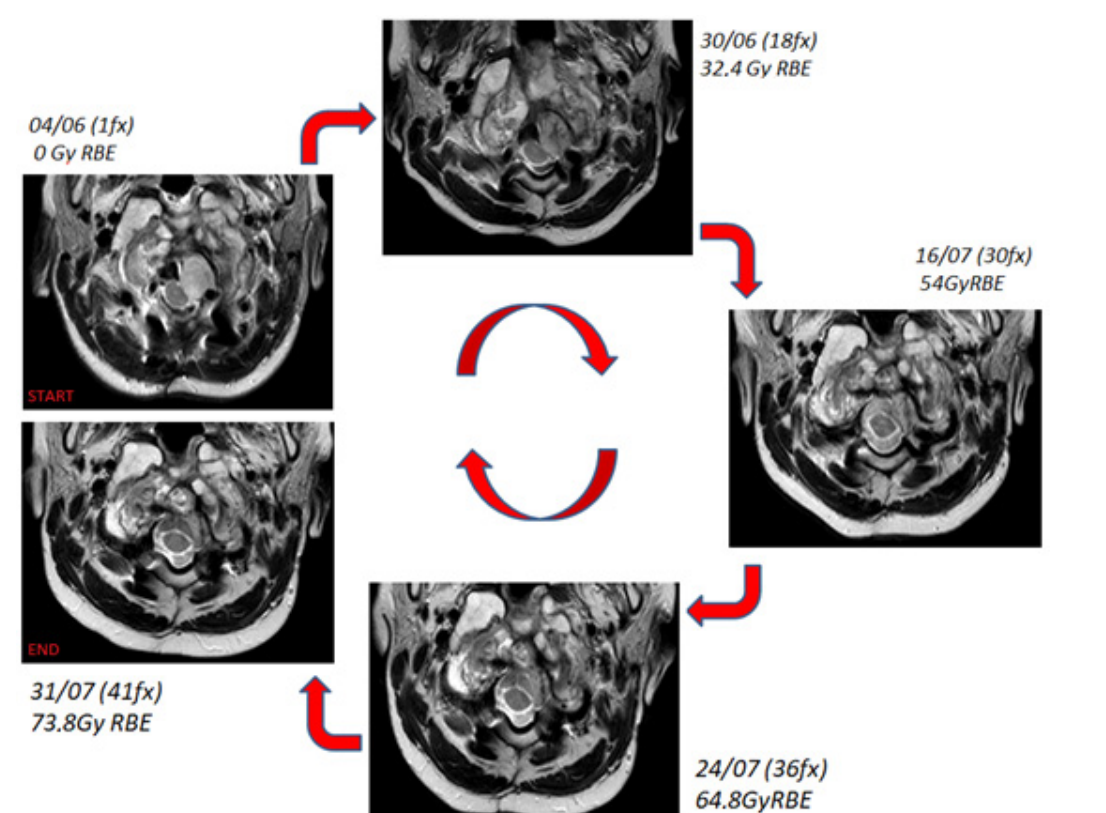
Figure 4. Treatment monitoring over the proton therapy course with T2-weighted MRI.